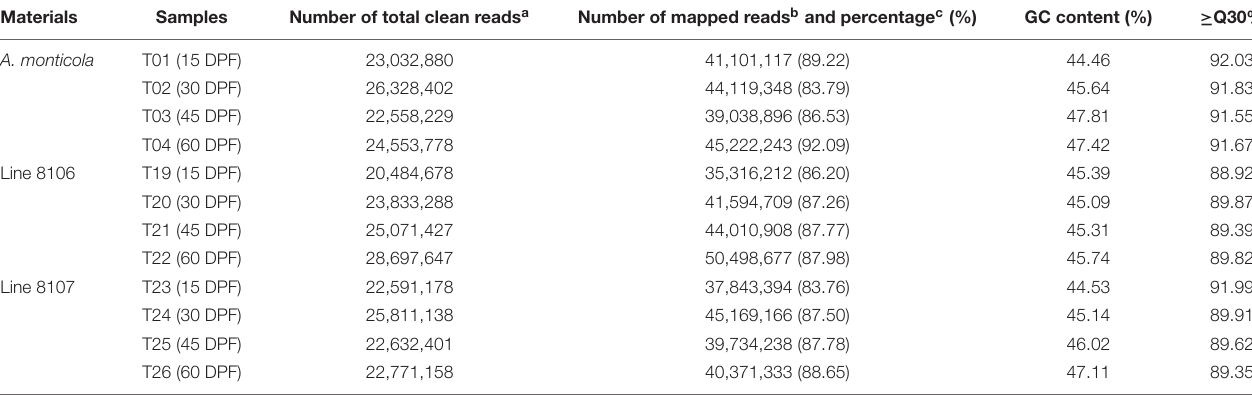
FIGURE 1 | Seed phenotypes of three peanut accessions at four seed developmental stages. (A) Seed samples at 15, 30, 45, and 60 DPF from A. monticola ( A. mon ), Line 8106, and Line 8107, scale bar = 1 cm. Panels (B,C) show the changes in average size and weight for seeds from A. mon , Line 8106, and Line 8107 from 15 DPF to maturity. One-way analysis of variance was performed. Significant level, α = 0.05. TABLE 1 | Summary of RNA-seq data for 12 seed samples from Line 8106, Line 8107 and A. monticola at 15, 30, 45, and 60 days past flowering.